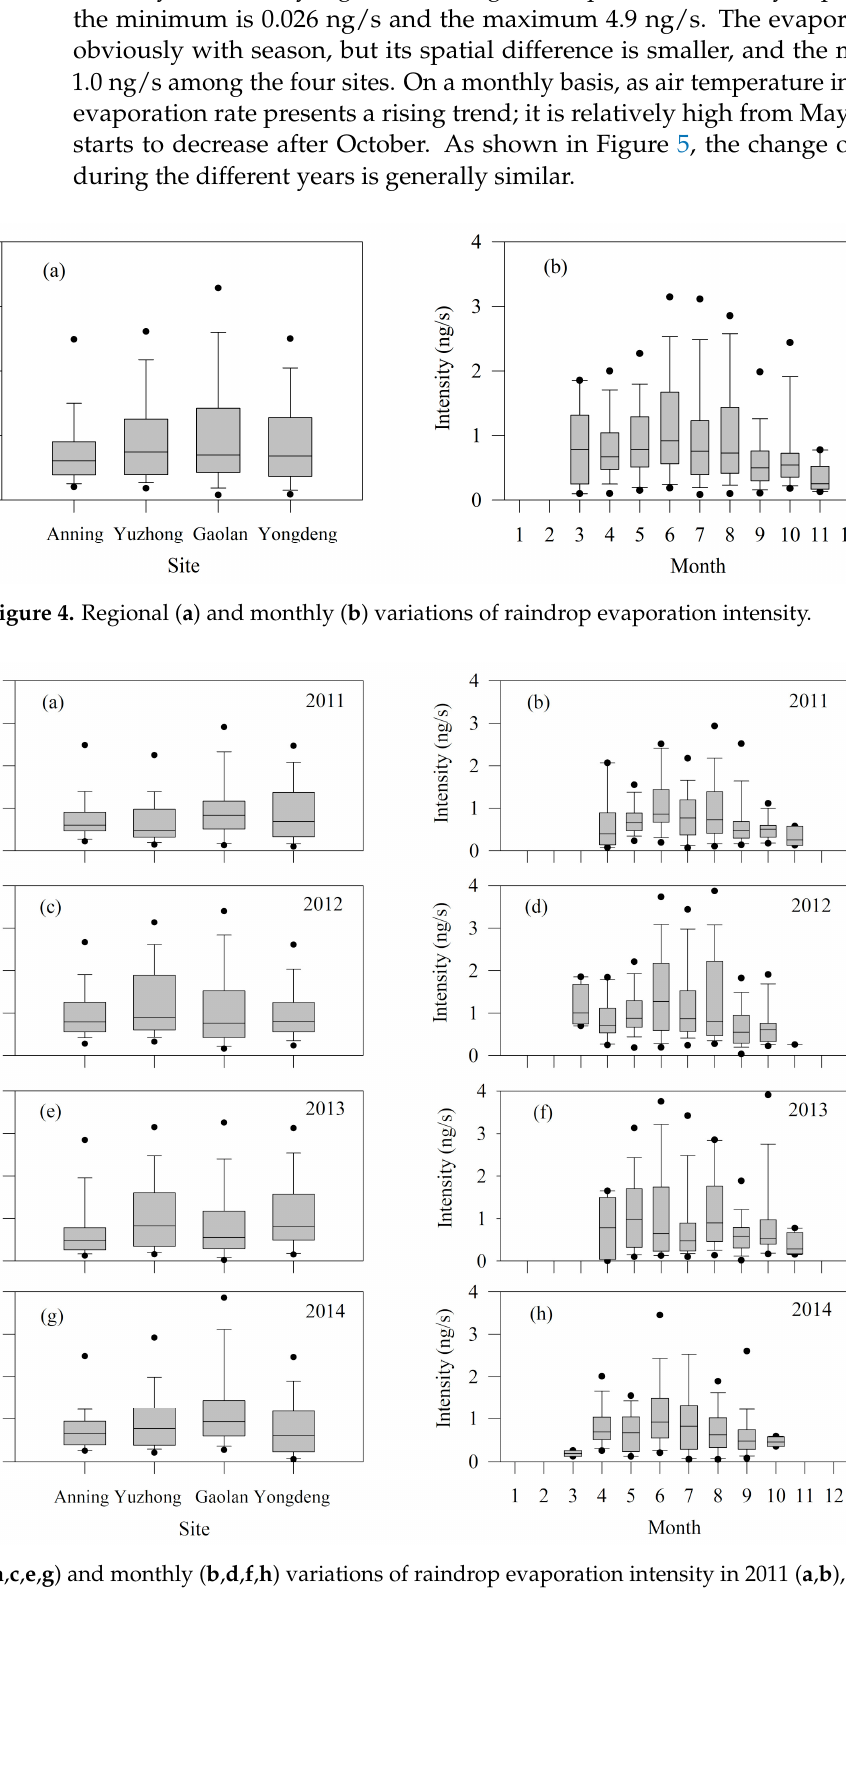
Figure 3. Frequency of precipitation events for different terminal velocities: ( a ) Lanzhou and ( b ) four sampling sites.